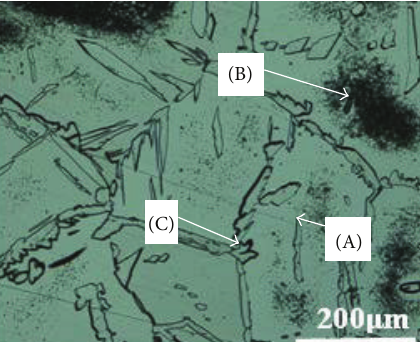
Figure 3: Optical microstructure of the HTHAZ of the weld section (A- 𝛼 -ferrite, B- 𝛿 -ferrite, and C-martensite).